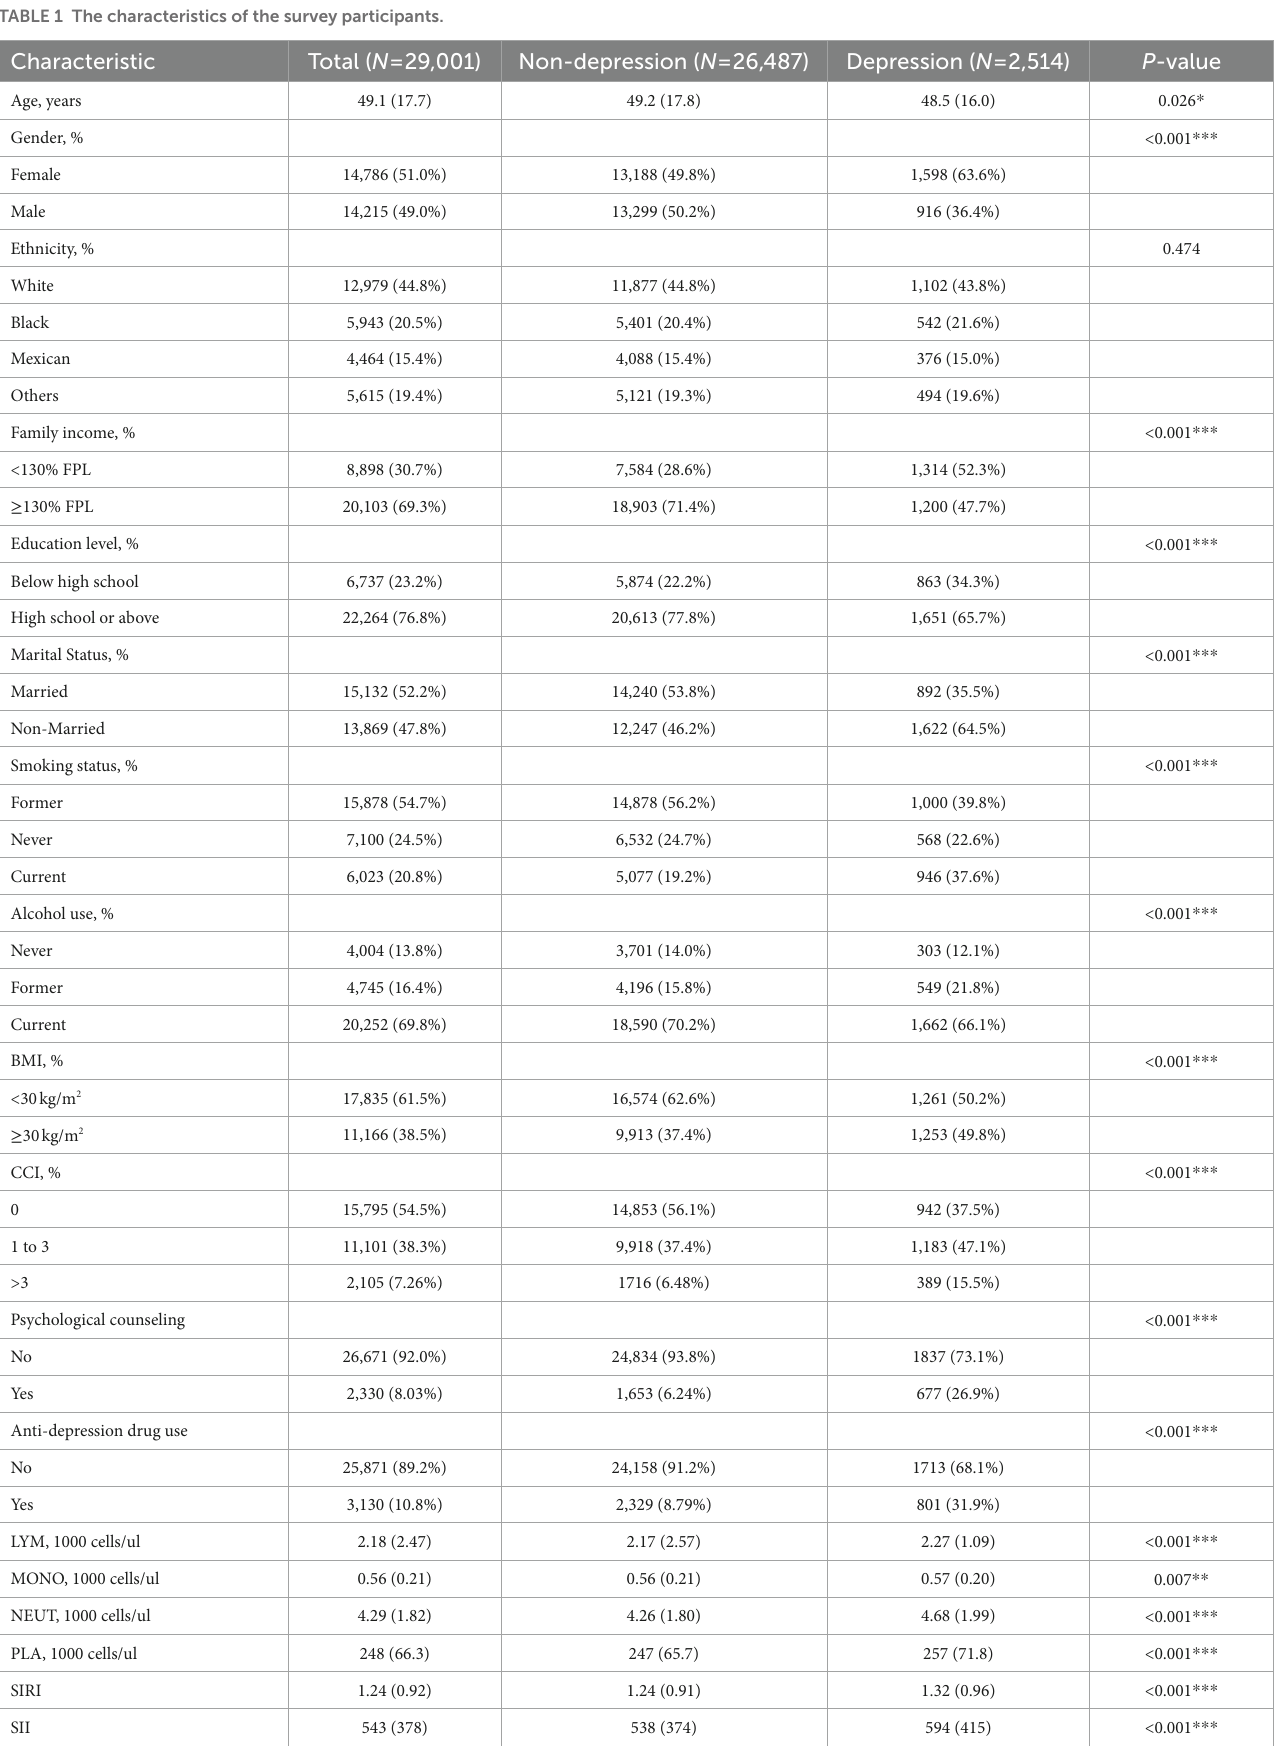
TABLE 1 The characteristics of the survey participants.